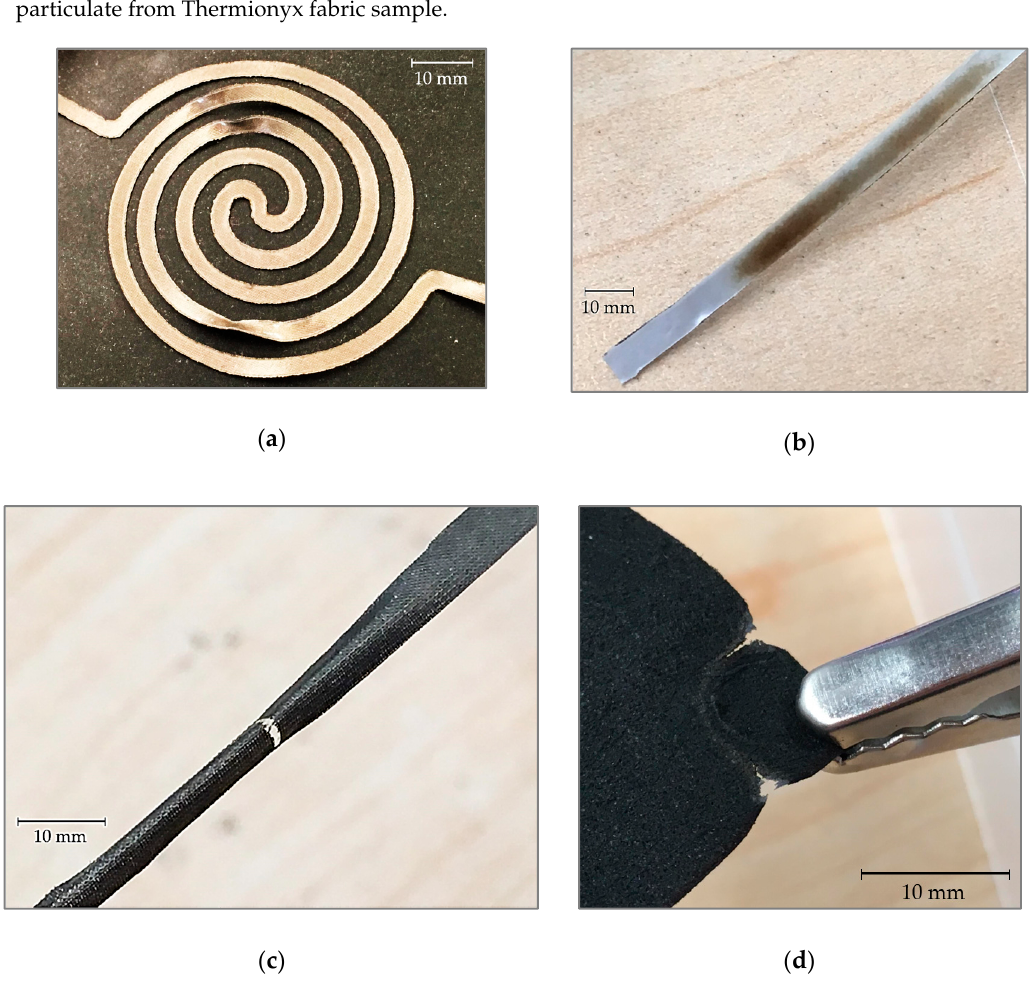
Figure A6. Fabrics burning at high temperature. ( a ) Polyester tape SS-3 sample discoloring and warping from heat; ( b ) polyester tape strip discoloration through adhesive cover; ( c ) Ni-Cu-Ni double-sided fabric tape strip disconnection at burnout temperature; ( d ) Thermionyx fabric burning out around alligator clip at burnout temperature.